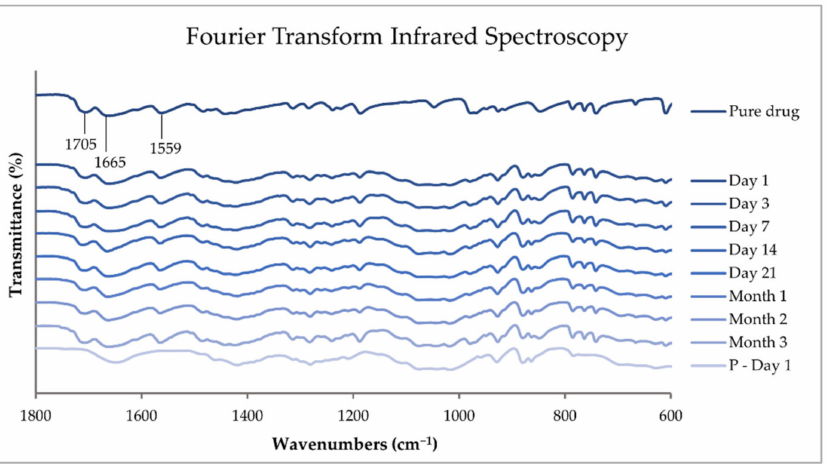
Figure 7. ATR-FTIR spectra of pure theophylline and drug-loaded printed ChewTs were measured at the different stability study time points, and drug-free placebo (P) extrudate was measured on day 1 of the stability